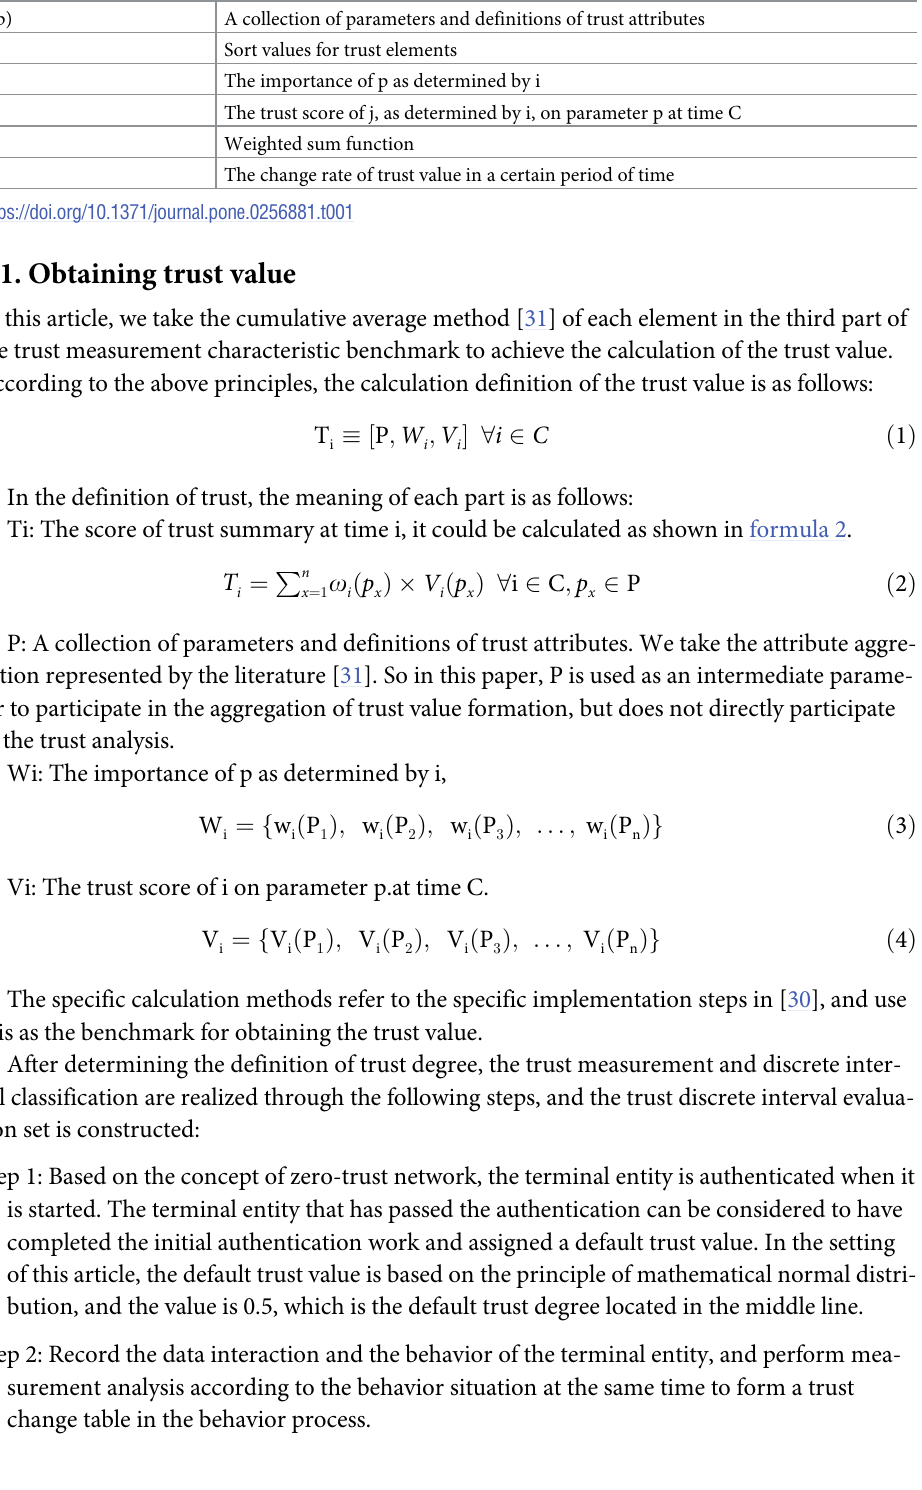
Table 1. Symbol definition table used in this paper. Symbol Definition i The trust measure is between i and j at a certain time point P(p) W The importance of p as determined by i V The trust score of j, as determined by i, on parameter p at time C F T